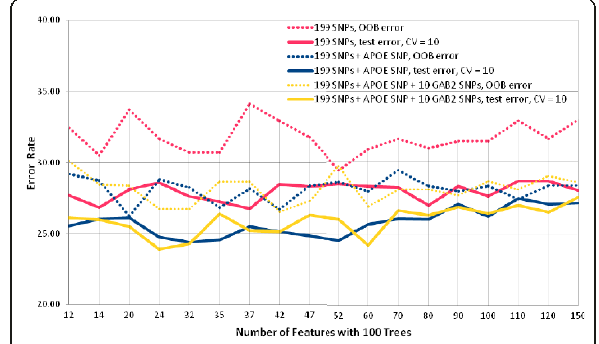
Figure 1 RF performance assessment, different number of features and number of trees fixed at 100; approach I